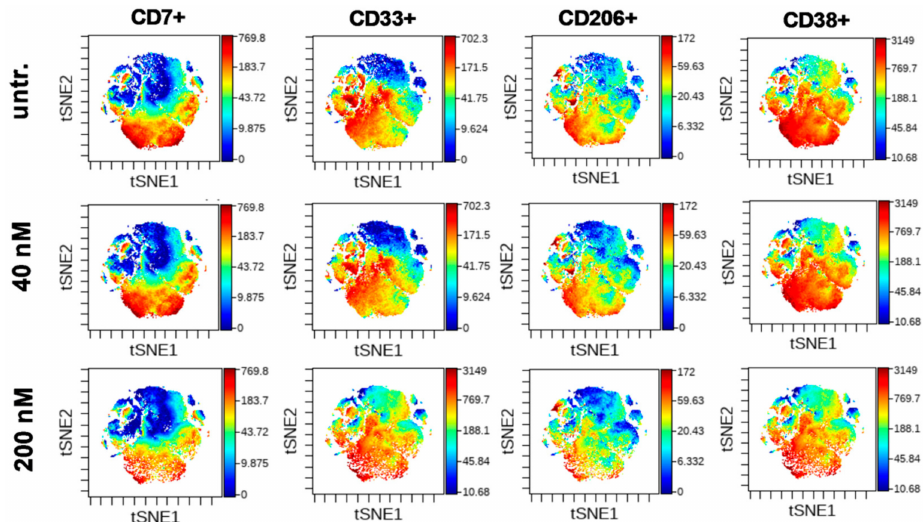
Figure 8. The most sensitive cells to DU325 treatment were CD7 + , CD33 + , CD206 + , and CD38 bright . The multidimensional viSNE plots of mass cytometry experiments illustrate the expression intensity of CD7, CD33, CD206, and CD38 markers showing a partial overlay, common marker expression of these subpopulations of human AML2 patient-derived cells. The coloration is proportional to the expression intensity (blue = low, red = high). The AML2 cells were treated with 40 nM or 200 nM DU325 ex vivo for 48 h. The viSNE plots of the rest, the other 11 markers can be found in Figure S9, the list of all antibodies used for mass cytometry can be found in Section